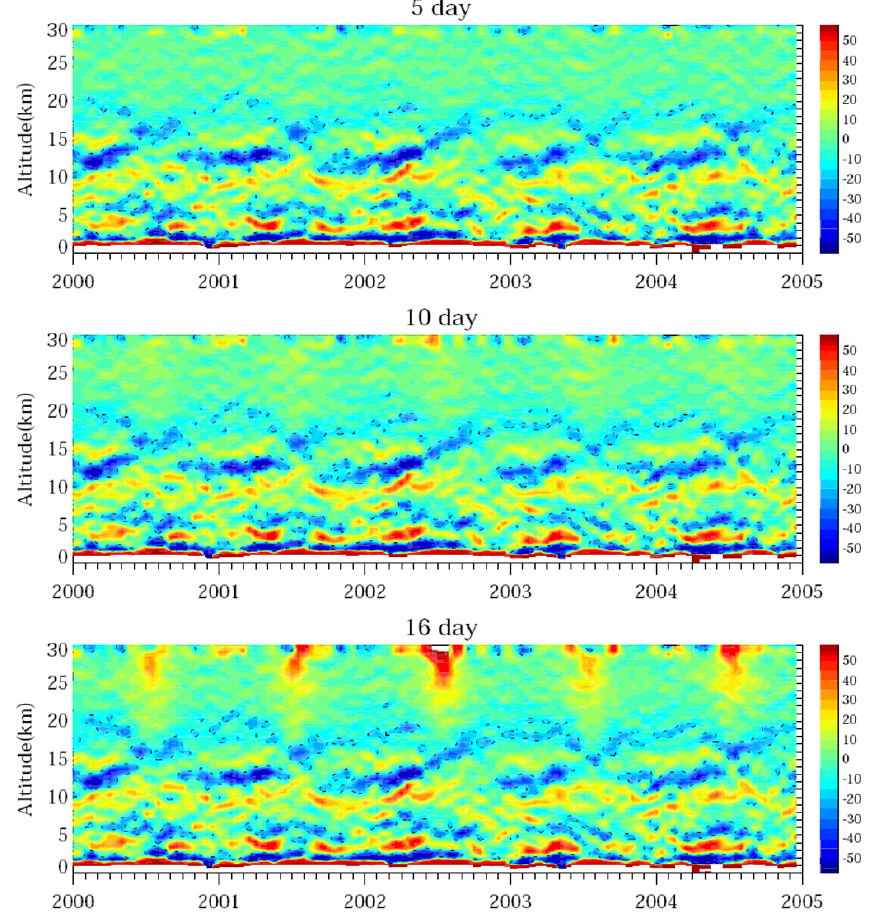
Fig. 5. Time-height cross-sections of refractive index squared υ 2 of quasi 5-, 10- and 16-day waves over Fort Worth Station during 2000–